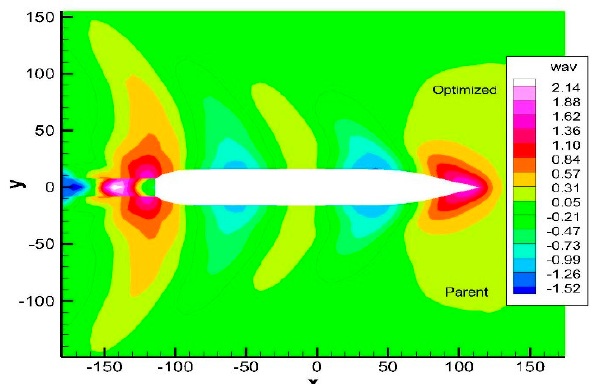
Figure 13. Comparison of wave elevation distribution by SWAN2. Table 5. Results of the second step of optimization.